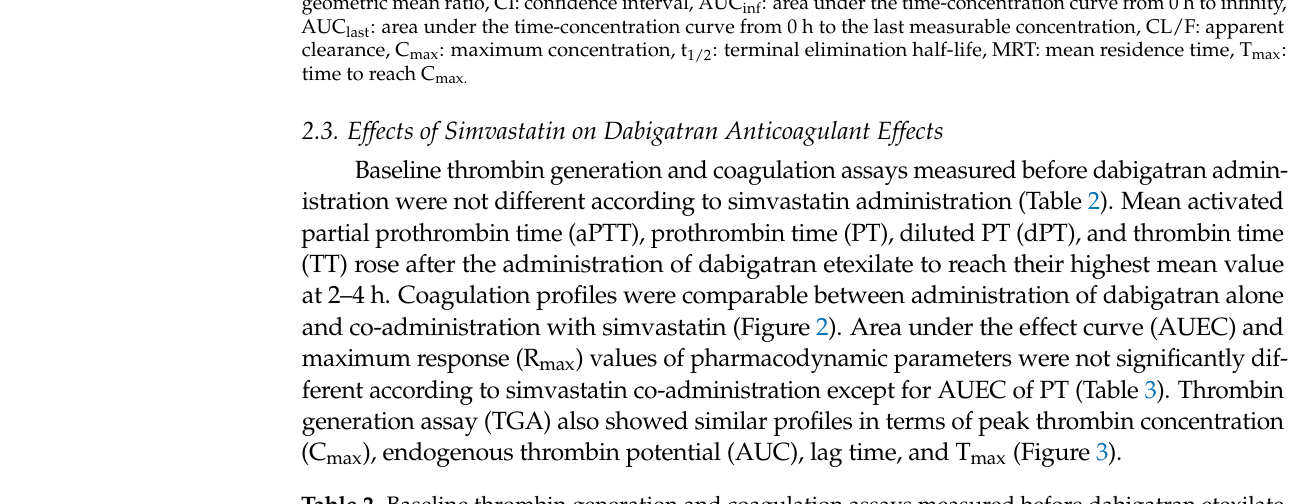
Table 2. Baseline thrombin generation and coagulation assays measured before dabigatran etexilate